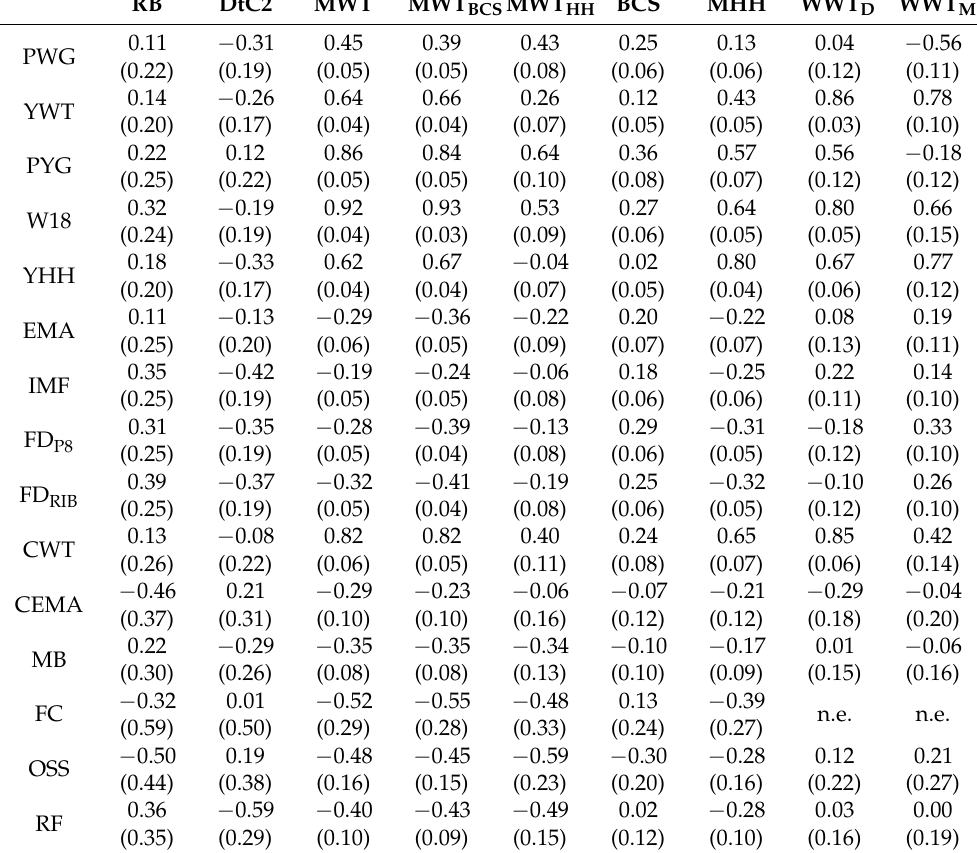
Table 6. Genetic correlations (SE) among maternal and finishing traits in New Zealand beef